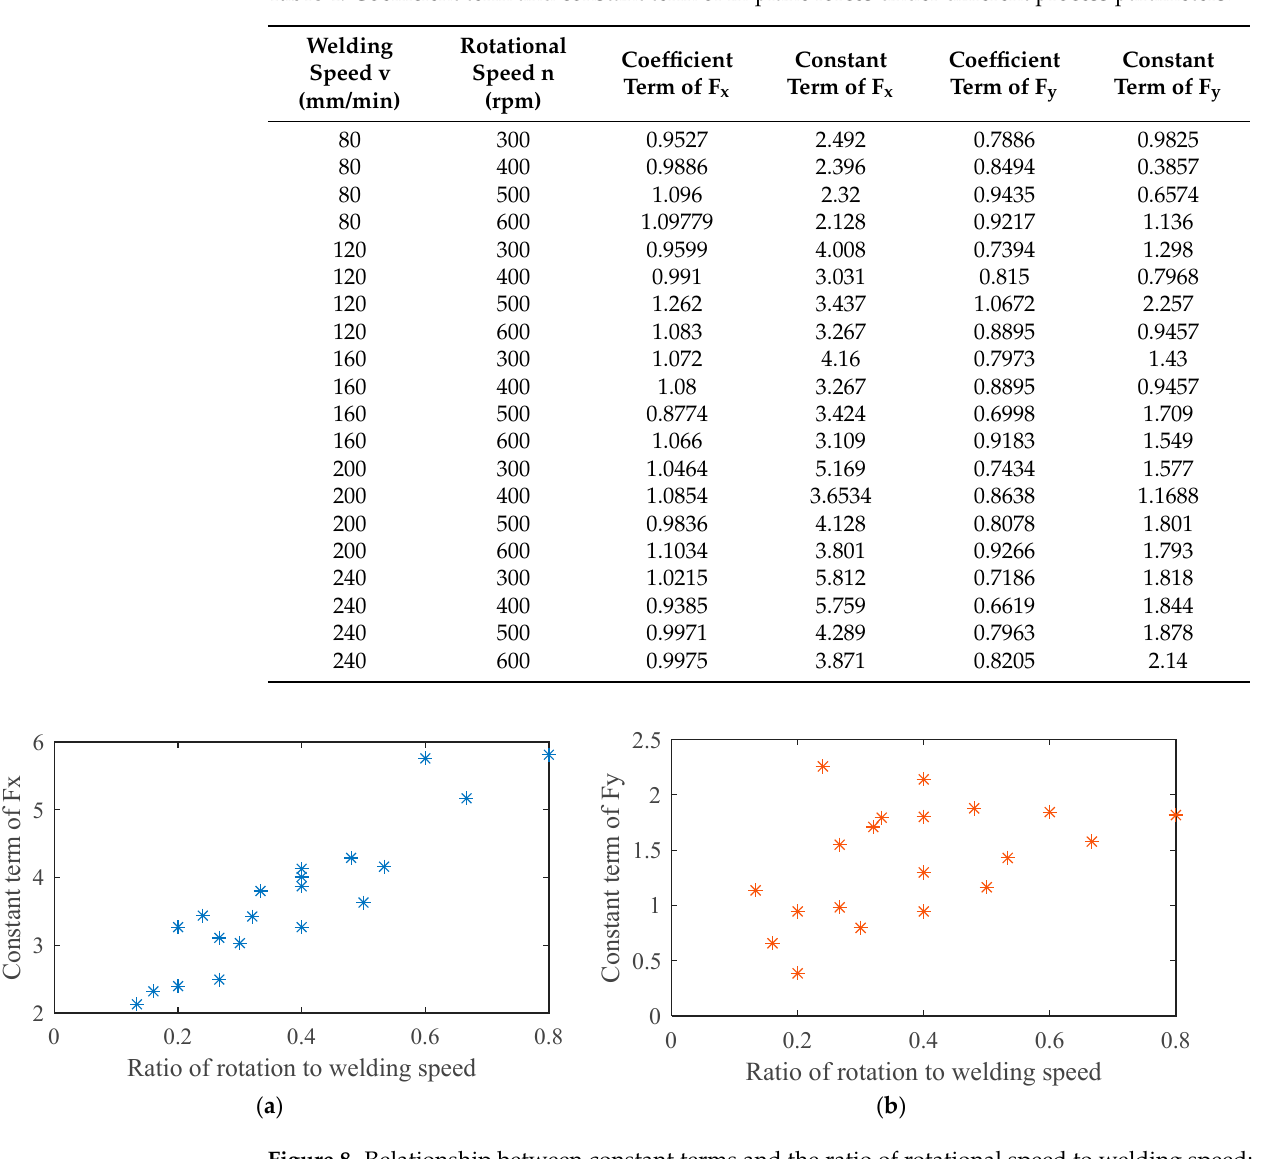
Table 4. Coefficient term and constant term of in-plane forces under different process parameters.